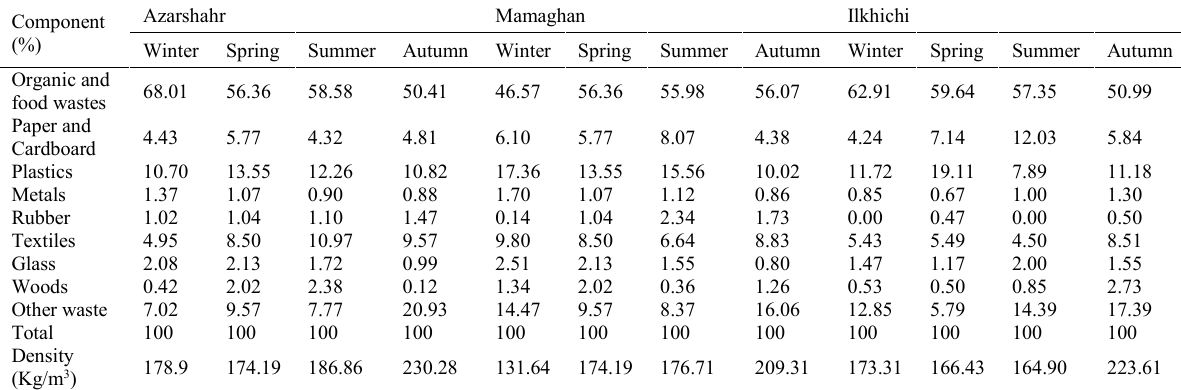
Table 3. Seasonal waste composition and density in 3 studied cities Component (%) Organic and food wastes Paper and